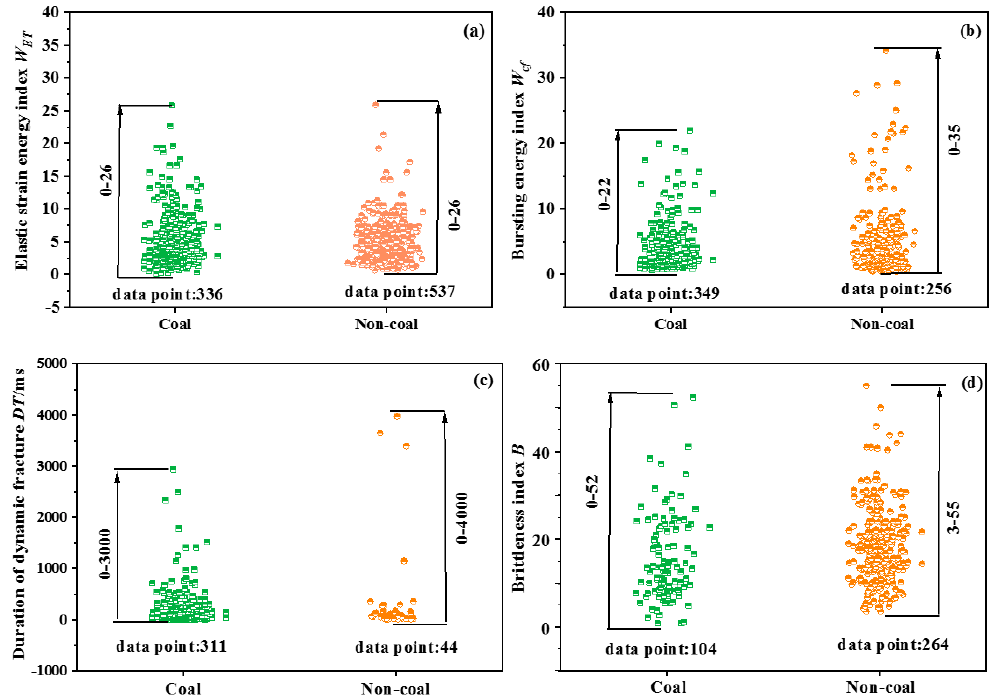
Figure 7. Statistics of bursting liabilities of coals and non-coal rocks: ( a ) elastic strain energy index W ET , ( b ) bursting energy index W cf , ( c ) dynamic fracture duration time DT , ( d ) brittleness index B. Table 2. Statistical parameters of the rockburst indices of coals and non-coal rocks.